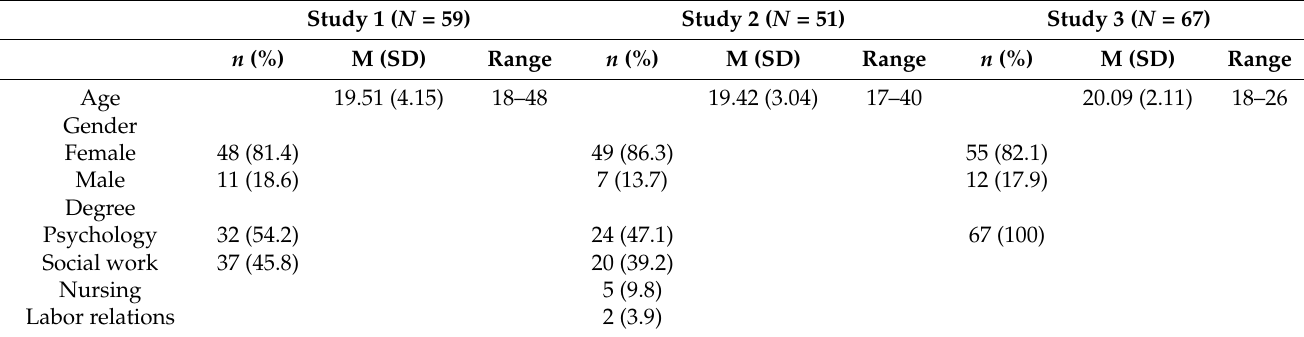
Table 2. Descriptive statistics for sociodemographic characteristics of each study after data